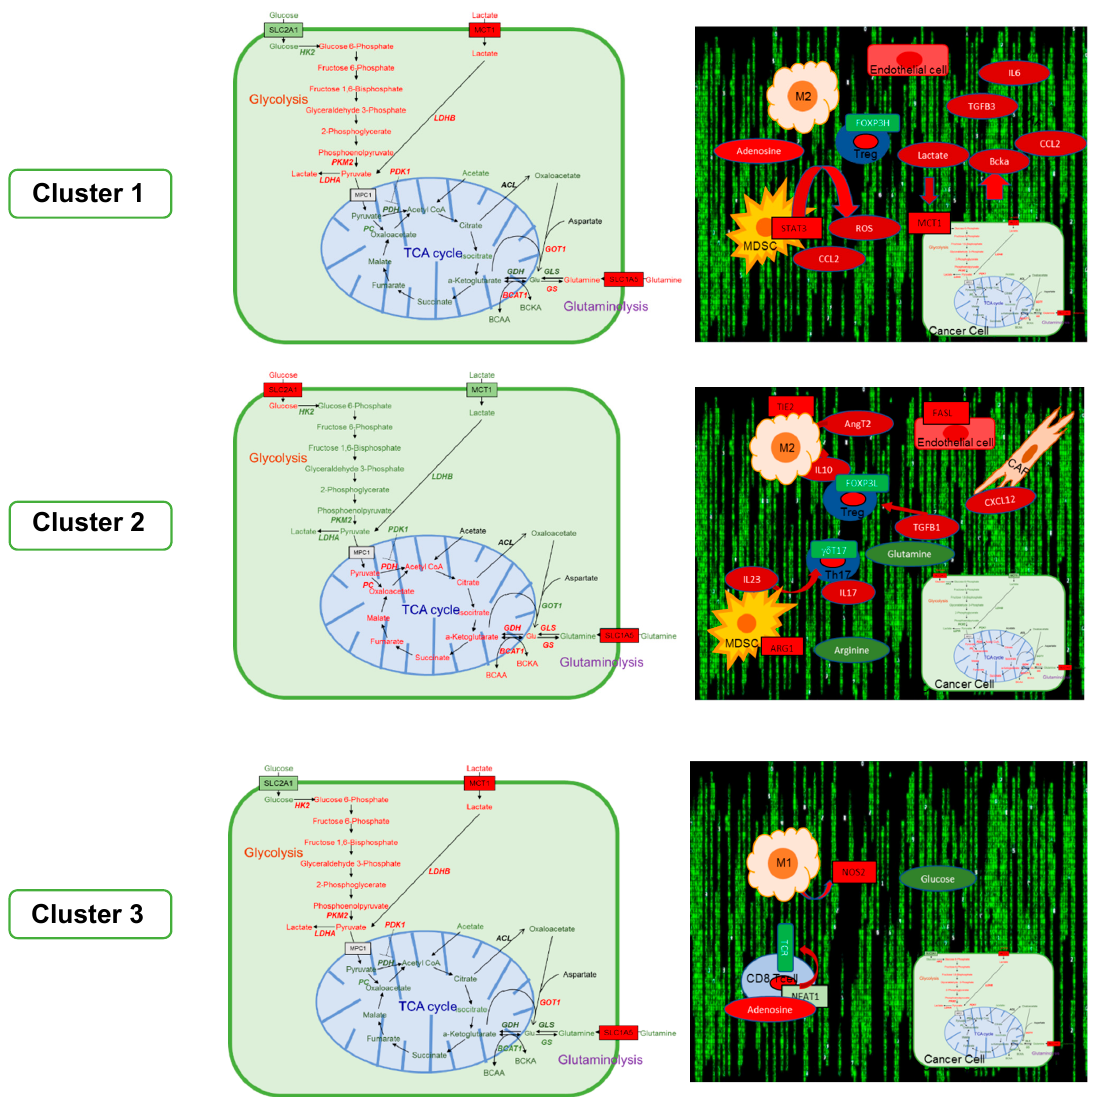
Figure 1. Major metabolic modules and tumor microenvironment interactions inferred for the GAstrointestinal Immune-Signature (GAIS)-42 immune clusters. Left panels. Major cluster-specific metabolic modules inferred for tumor cells are highlighted in red (up-regulated) or green (down-regulated). Di ff erential expression of corresponding enzyme / metabolite is indicated by color (red, up-regulated; green, down-regulated). Right panels. Interactions between tumor cells, stromal fibroblasts, and tumor-infiltrating lymphocytes (TILs). Round nodes represent metabolites and square nodes represent enzymes. Abbreviations: ACL, ATP-citrate synthase; ANGT2, angiopoietin 1; ARG1, arginase 1; BCAA, branched-chain-amino-acid aminotransferase; BCAT1, branched-chain-amino-acid aminotransferase, cytosolic; BCKA, branched-chain